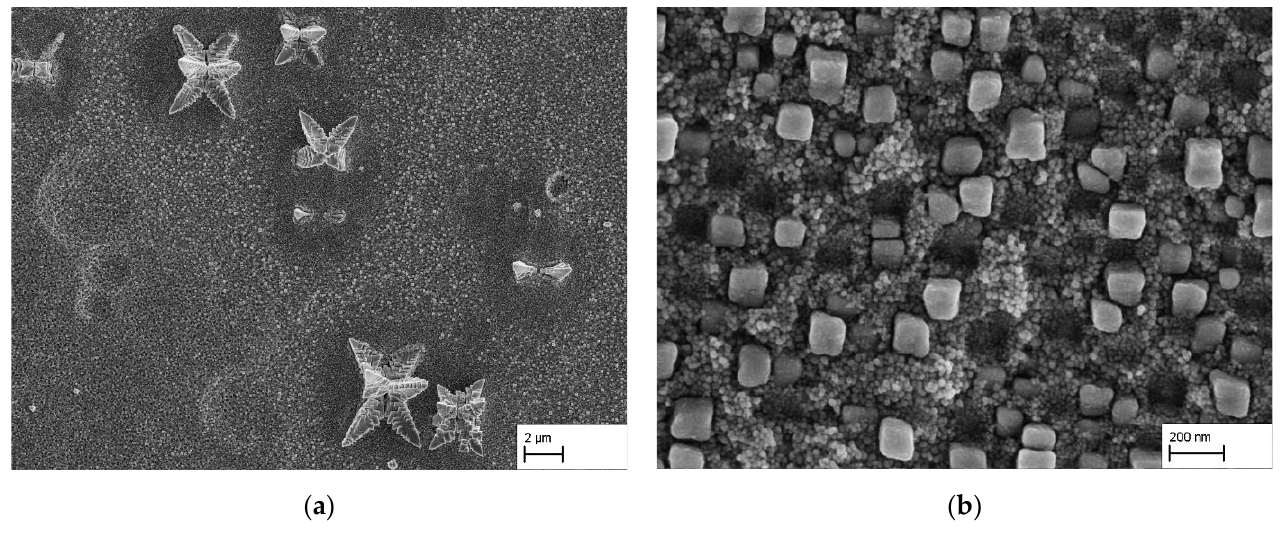
Figure 1. Deeply etched specimen with γ’ -precipitates after slow cooling to 1165 °C. ( a ) Coarse particles with visible diffusion zones around them and fine cubes along with very fine round particles due to rapid cooling in the surrounding areas. It can be seen that the diffusion zones of the individual coarse particles overlap only in a few cases. ( b ) Magnification of the precipitates due to the rapid cooling in the surrounding areas.